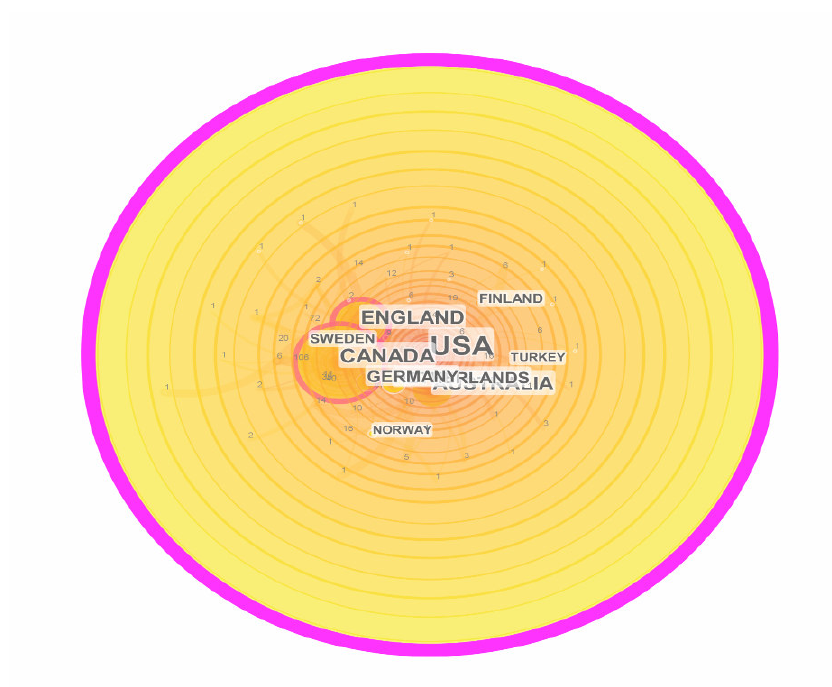
Figure 3. The Network Structure of the Citations by